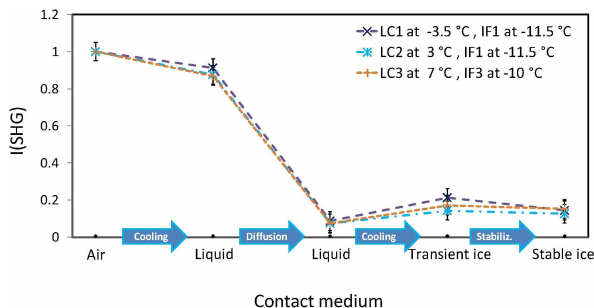
Figure 4. SHG intensity measured at the surface of mica in con- tact with air, liquid film, liquid bulk, transient ice bulk, and stable ice bulk, collected in an SM polarization combination during three different cooling cycles. LC1 IF1: sample cooled down under flow of water vapor of RH = 20%. LC2 IF2: sample cooled down under flow of water vapor of RH = 30%. LC3 IF3: sample cooled down under flow of water vapor of RH = 40% (see text for details). The signal is Fresnel-corrected and normalized to the air value. Data be- fore Fresnel correction are shown in Fig. S4 in the Supplement. All connection lines between points serve to guide the eye.